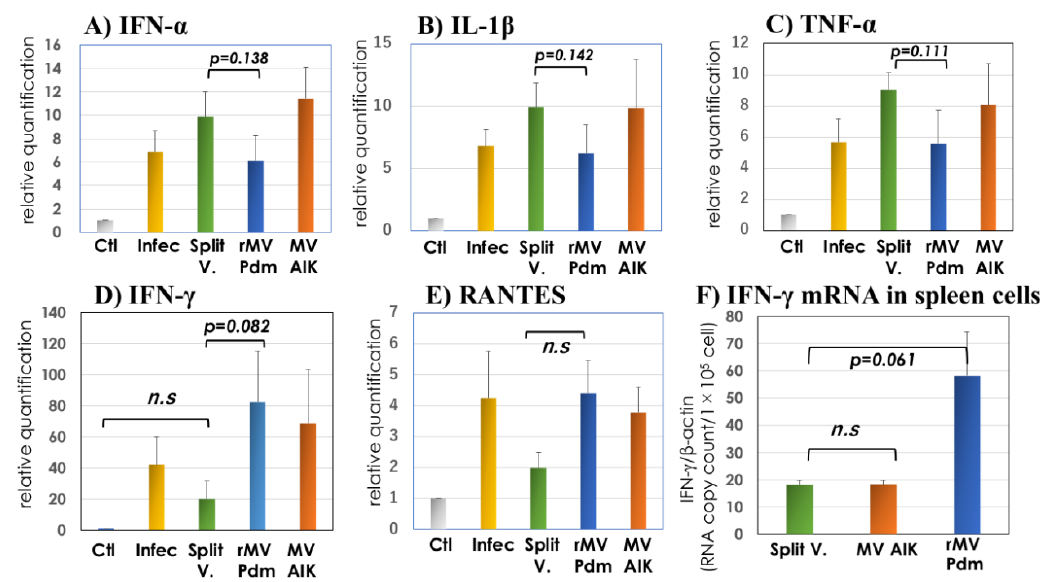
Figure 6. Detection of mRNA in lung homogenates and IFN- γ mRNA in spleen cell cultures stimulated with influenza antigen. Relative quantification of IFN- α ( A ), IL-1 β ( B ), TNF- α ( C ), and IFN- γ ( D ), and RANTES ( E ) mRNA in lung homogenates from control (Ctl), non-immune infection (Infec), HA split vaccine (Split V.), MVAIK / PdmHA (rMVPdm), and empty vector (MVAIK) groups. ( F ) Spleen cells were cultured and stimulated with UV-inactivated A H1N1 / California / 07 / 2009 Pdm. Vertical column represents mean + SE.